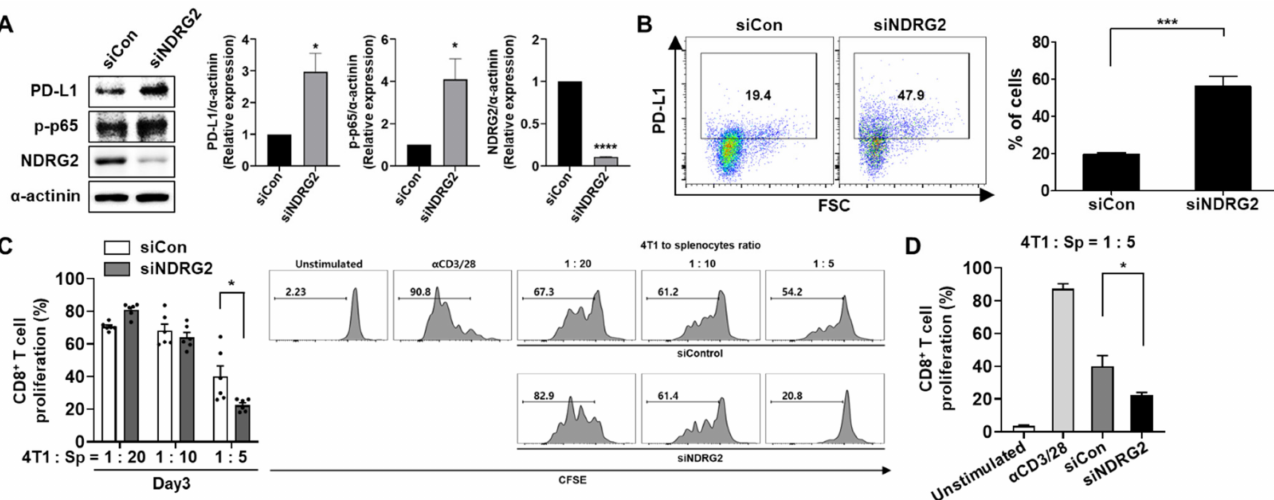
Figure 5. siRNA-mediated knockdown of NDRG2 restores PD-L1 expression and T cell suppression activity. 4T1-NDRG2 cells transiently transfected with control or NDRG2 siRNA were cultured in fresh medium (DMEM or RPMI) supplemented with 10% FBS. ( A ) Protein levels of NDRG2, p-p65, and PD-L1 in 4T1-siControl and 4T1-NDRG2–siRNA transfectants were measured by Western blot analysis. ( B ) PD-L1 expression on the surface was confirmed by flow cytometry. ( C , D ) Splenocytes were stained with CFSE and cocultured with transfected 4T1 cells for 3 days. The cells were harvested and analyzed by flow cytometry. The cells were gated on CD8 + cells, and the histogram represents the CFSE level. All experiments were independently repeated at least 3 times. * p < 0.05, *** p < 0.001, and **** p < 0.0001. The uncropped blots and molecular weight markers are shown in Supplementary